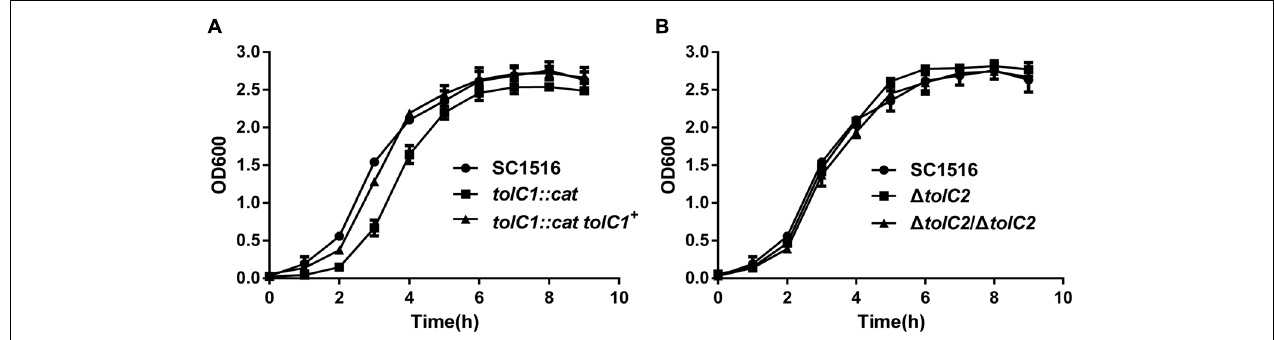
FIGURE 3 | Growth kinetics of the wild-type strain SC1516, tolC mutants and genetically complemented strains in TSB broth. (A) The tolC1 mutant showed a reduced growth rate in the log phage, while later reached similar optical density in the stationary phase. (B) The tolC2 mutant exhibited the same growth kinetics with the wild-type strain. Data presented here are means of triplicate experiments and error bars represent standard